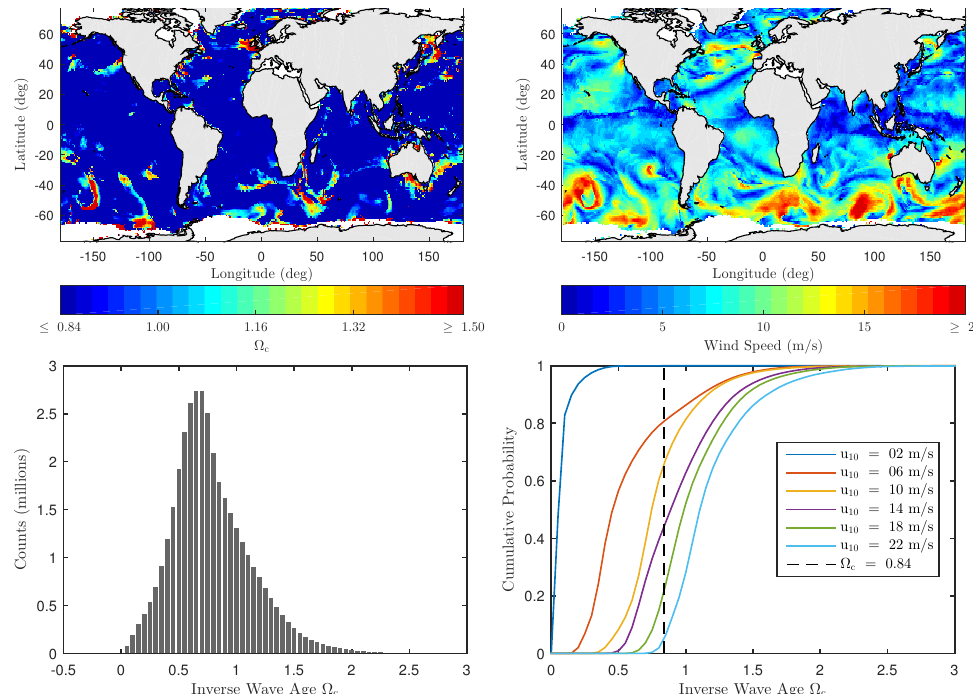
Figure 13. The WW3 inverse wave age Ω c and wind speed on 1 May 2015, at 00:00:00 UTC at glo_30m spatial resolution are shown on ( left ) and ( right ) plots of the ( top row ), respectively. The distribution of Ω c computed using Equation (32) for | φ m − φ w | ≤ 20 ◦ for all L1_C data files in Table 1 is shown in the ( bottom left ) plot. The Ω c dependence on wind speed is shown in the ( bottom right ) plot using cumulative distribution functions for multiple wind